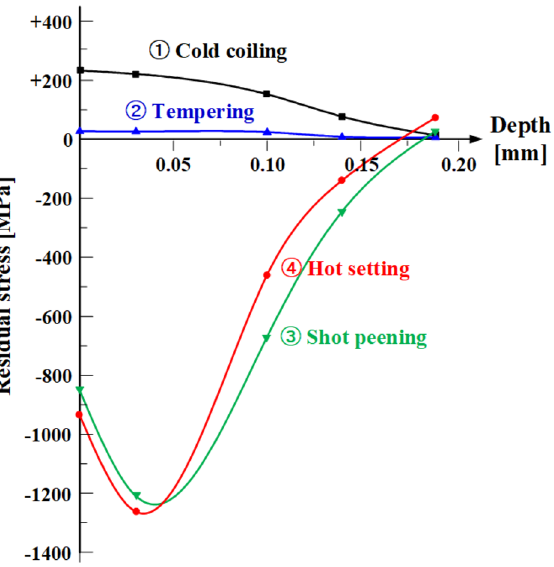
Figure 20. Residual stress and depth profile of the inner surface layer of cold-formed spring after each spring manufacturing process.